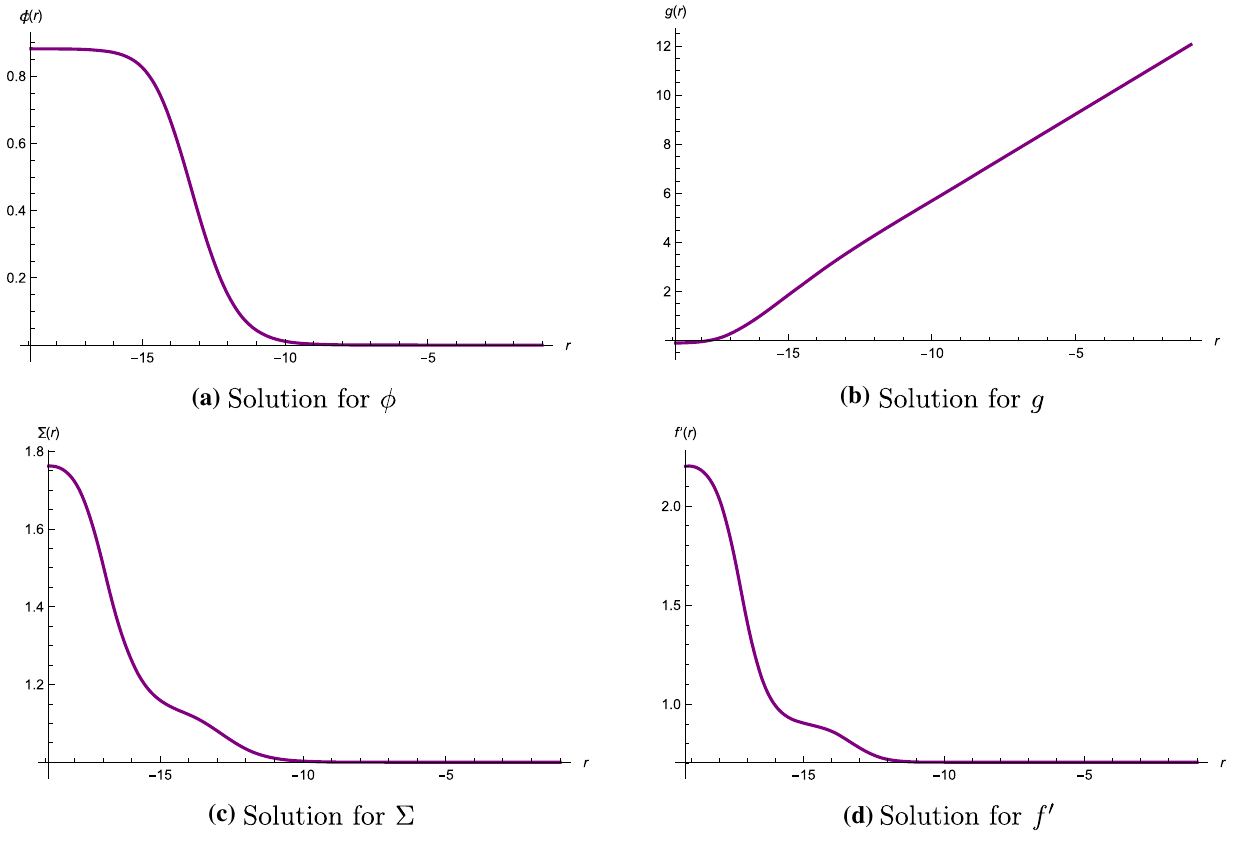
Fig. 8 An RG flow from AdS 5 critical point with U ( 1 ) × SU ( 2 ) × SU ( 2 ) symmetry to AdS 5 critical point with U ( 1 ) × SU ( 2 ) diag symmetry and finally to AdS 2 × H 3 critical point for g 1 = 1 and g 3 = 2 g